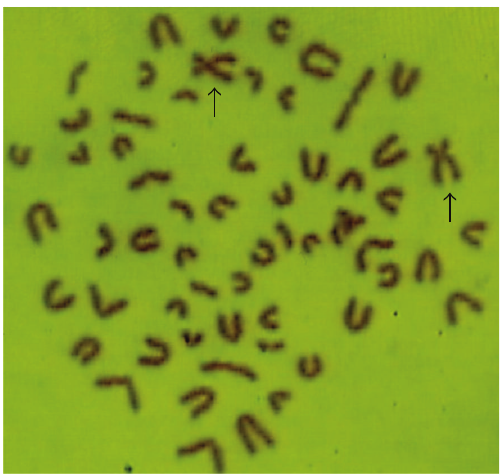
Figure 3: Cytogenetic analysis of the heifer with athelia. The heifer showed normal chromosomal set with XX chromosome